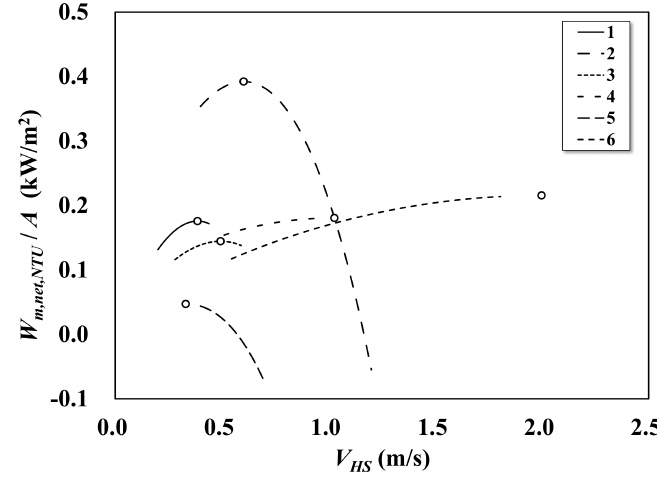
Figure 5. The net power output per the heat transfer area as function of the mean velocity of heat source in the plate when T W = 30 ◦ C, T C = 5 ◦ C, c p = 4.0 kJ/kgK and ρ = 1025 kg/m 3 . The open circles show the maximum point of power output, i.e., the optimum mean velocity of the heat source in each plate heat